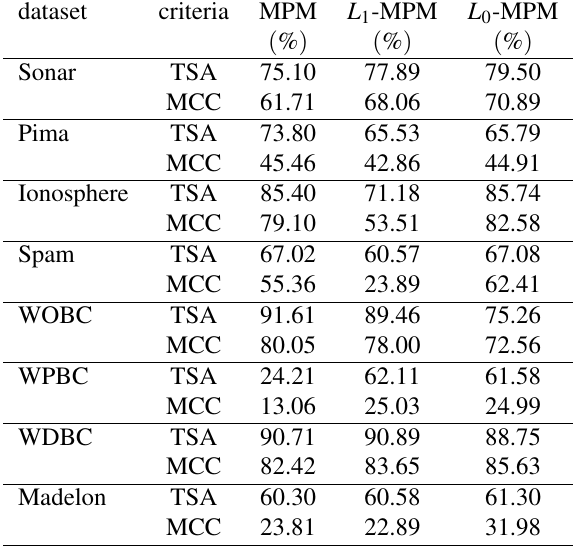
Table 3. Comparison of L 0 -MPM, MPM and L 1 -MPM in terms of TSA and MCC